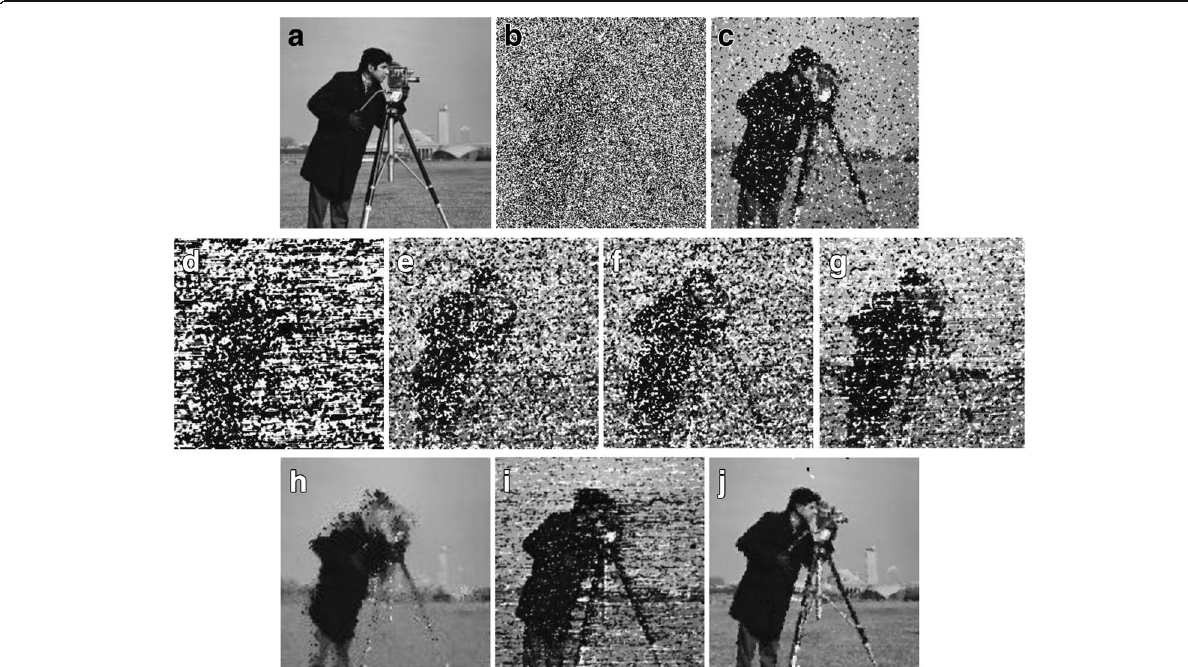
Fig. 8 Restoration results of different methods for Cameraman image corrupted with 80% noise density. Legends: a Cameraman (original image); b noisy image (80%); c NAFSWM; d ROAD; e ROLD; f TBLI; g ASM; h CBD; i AFIDM; and j TTSD